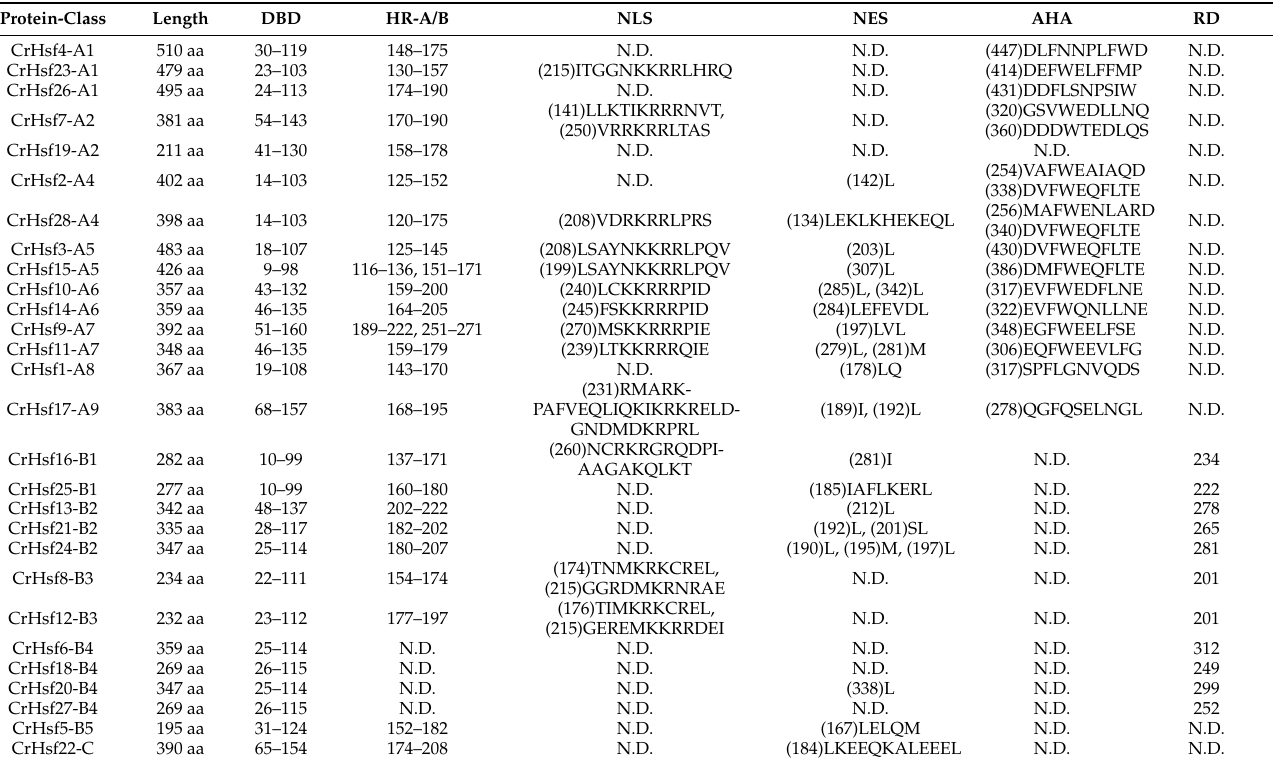
Table 2. Functional domains of